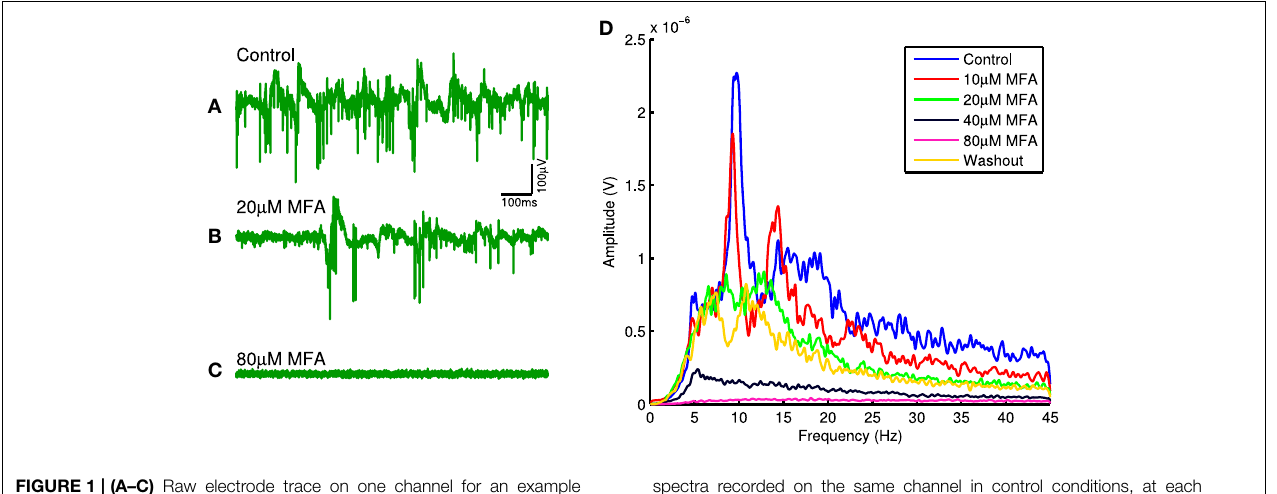
spectra recorded on the same channel in control conditions, at each drug concentration and after washout. Notice the overall decrease in LFP power as the drug concentration increases and the recovery upon